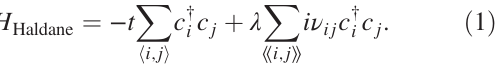
FIG. 1. Sign convention for ν direction from j to i is along (against) the directions indicated in the left